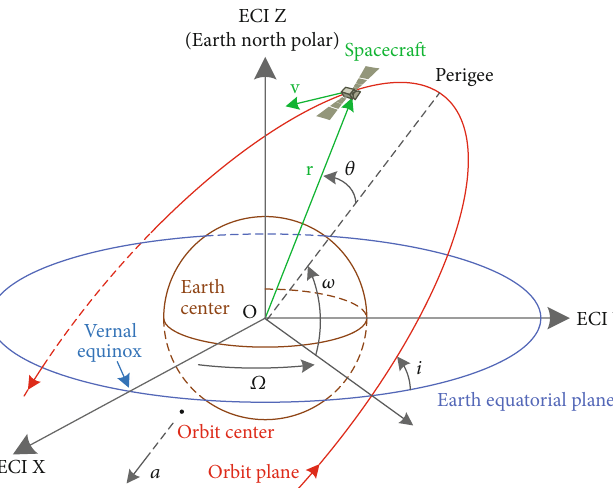
Figure 2: Simulation process.